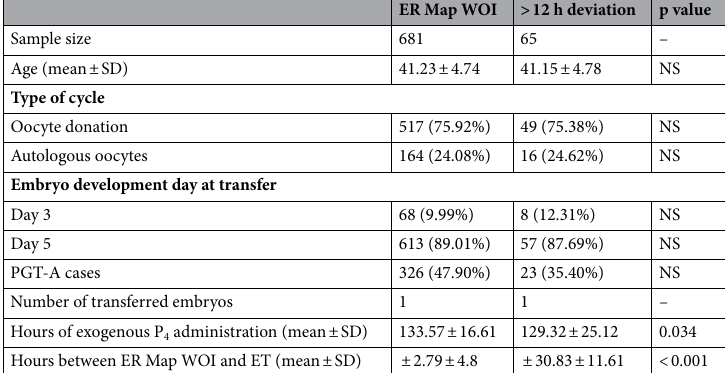
Table 1. Demographic and clinical characteristics of the patient population study